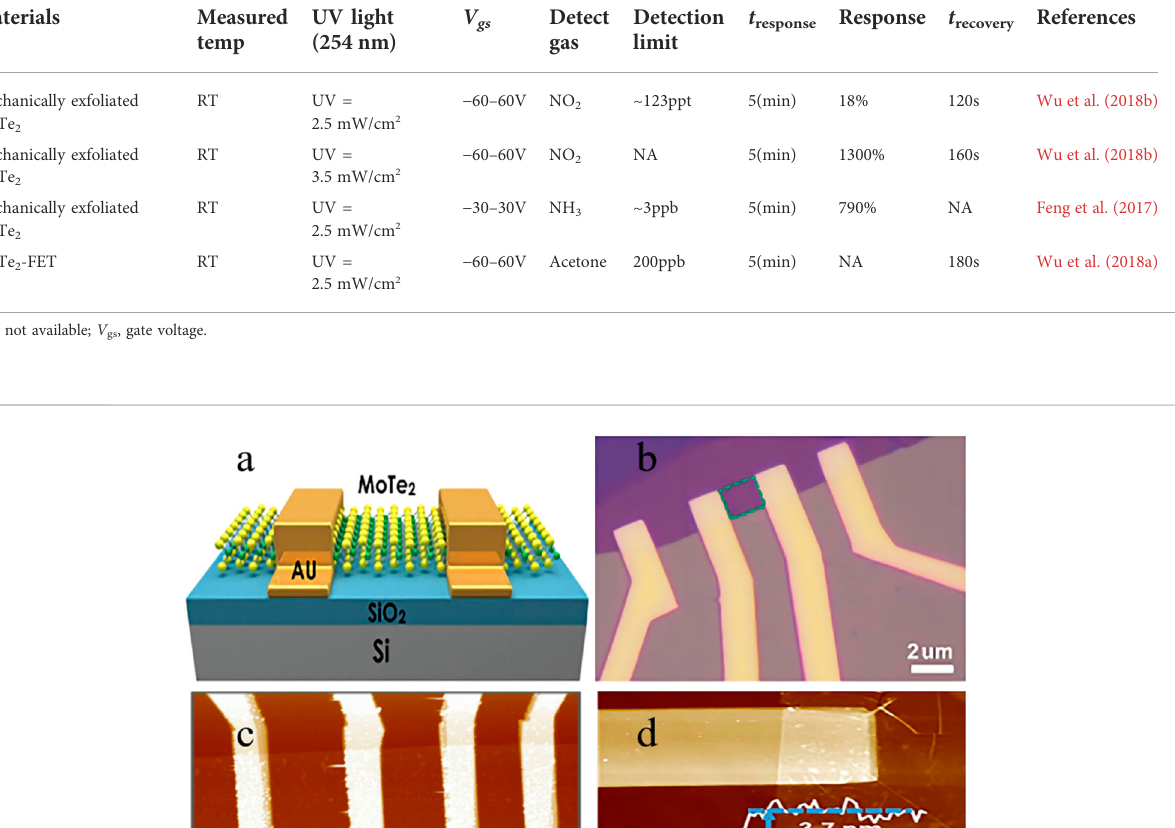
TABLE 1 Summary of gas sensing properties of MoTe 2 -based gas sensors activated by ultraviolet light.